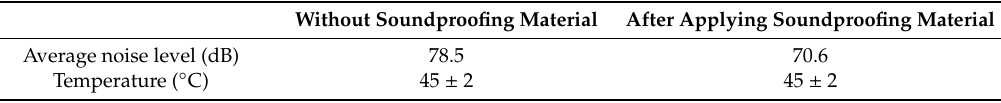
Table 3. Final selection and application of sound-absorbing and -insulating